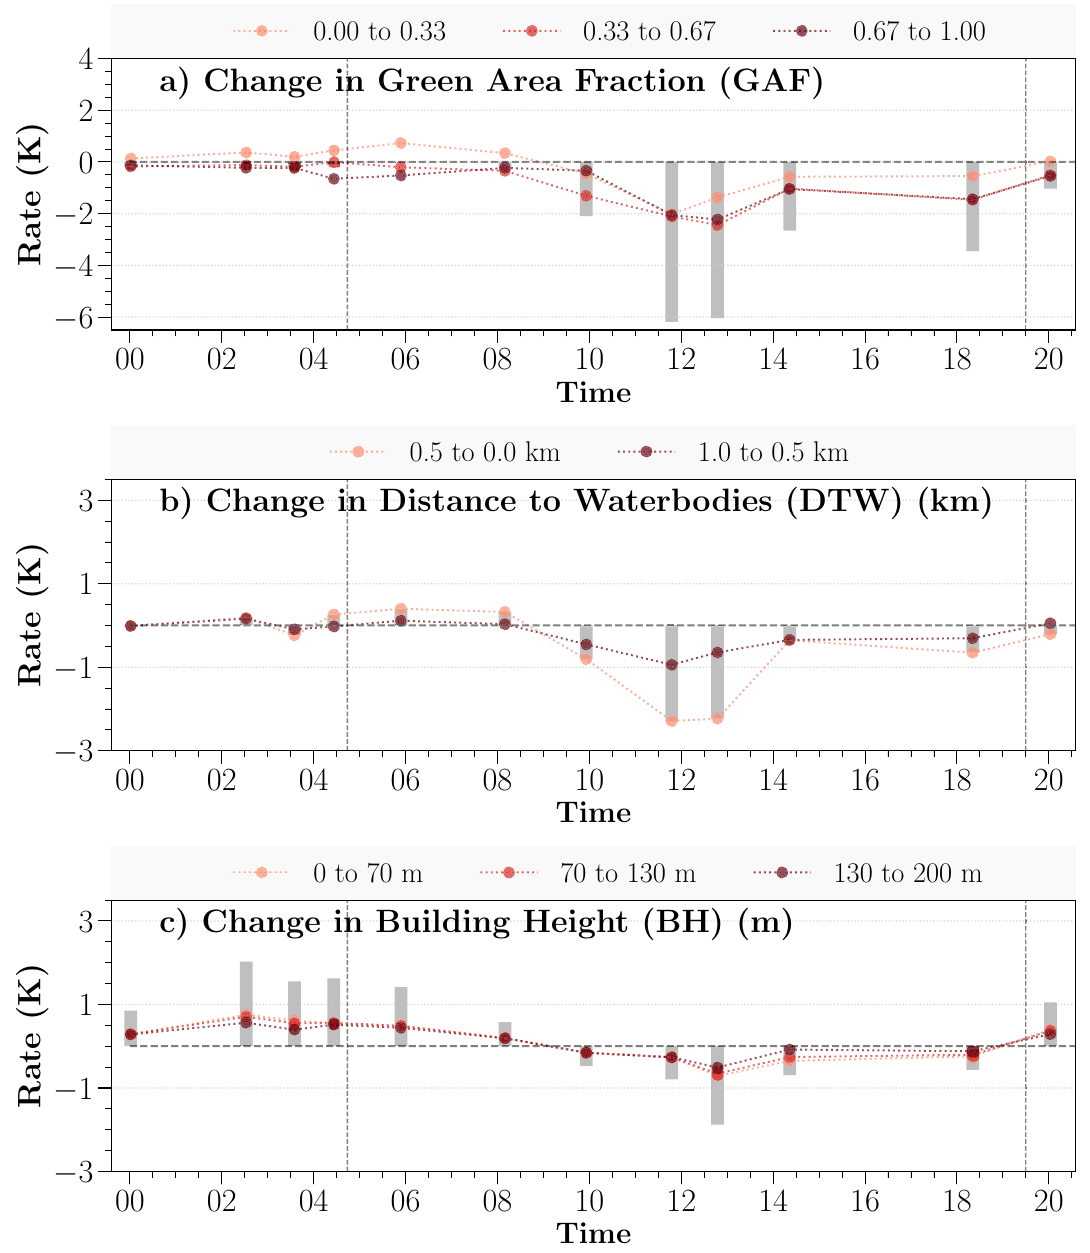
Figure 4. The diurnal change of canopy temperature controlled by three studied urban environmental factors: ( a ) for GAF, ( b ) for DTW, and ( c ) for BH. The colors distinguish the change in independent variable. The bars depict a possible total temperature effect from each selected variable of GAMs fittings, negative value for cooling and positive value for warming